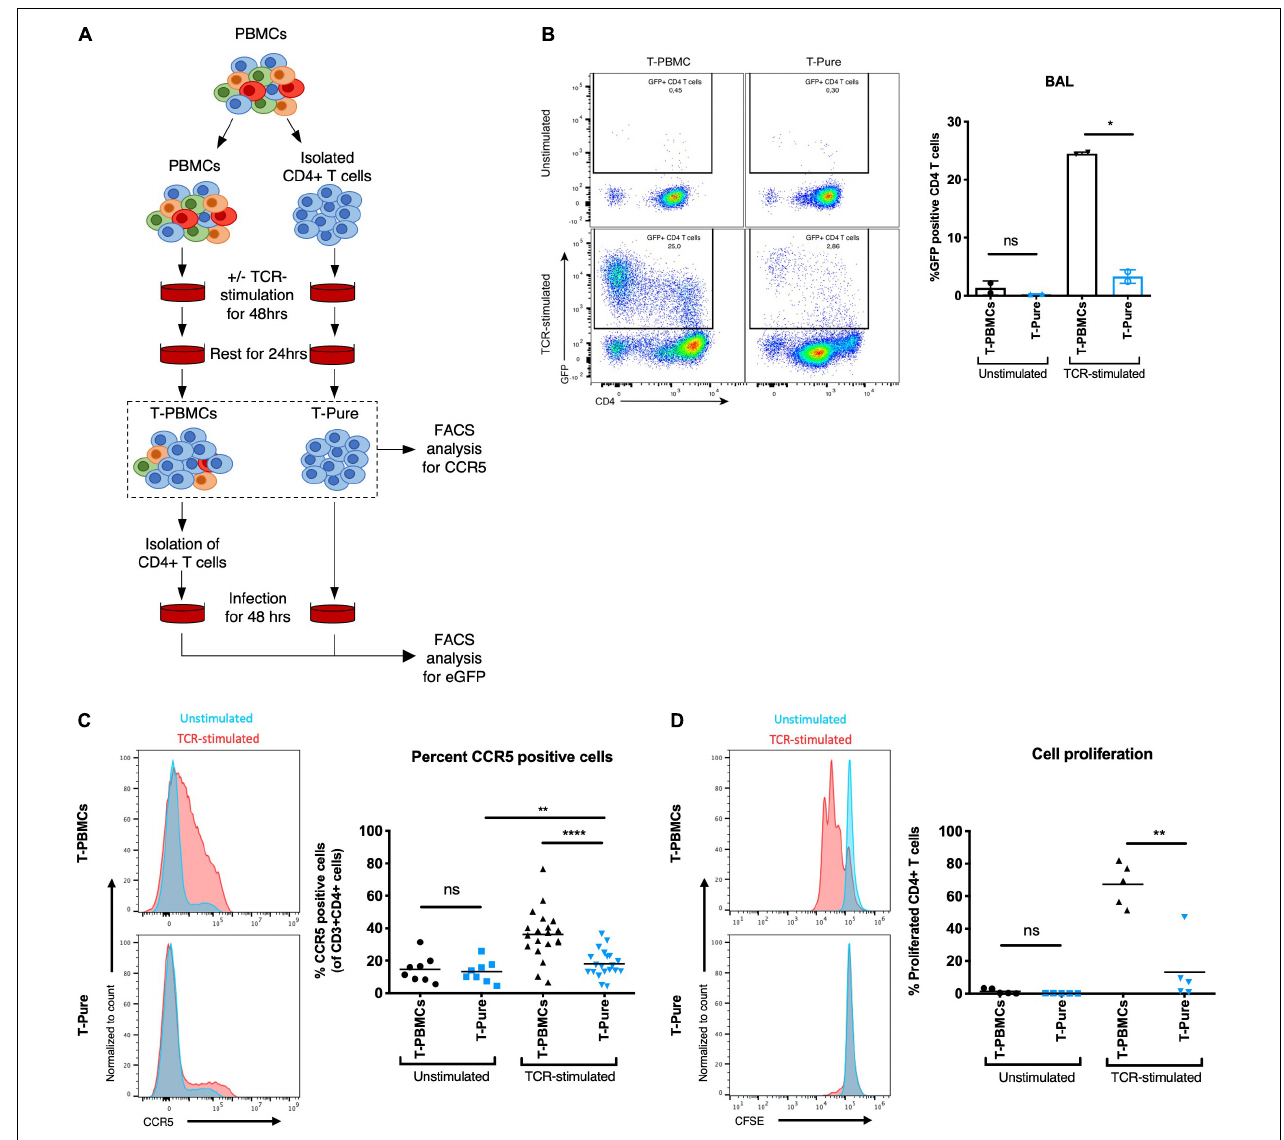
FIGURE 1 | CD4+ T cells from T- peripheral blood mononuclear cells (PBMCs) express elevated levels of cell-surface C-C chemokine receptor type 5 (CCR5) relative to those from T-Pure cultures. (A) Illustration of experimental setup to compare CD4+ T cells stimulated under different conditions. CD4+ T cells were mock-treated or stimulated with plate-bound α CD3(OKT3)/CD28(CD28.2) + IL-2 (termed TCR-stimulation) for 48 h either within the bulk PBMC population (termed T-PBMCs) or as a purified population of CD4+ T cells (termed T-Pure). Following T cell receptor (TCR)-activation, the cells were washed to remove antibodies and rested for another 24 h in the absence of stimulation. Cells treated in this manner were used for infection studies or analyzed by flow cytometry for CCR5 expression levels and proliferative capacity (B–D) . For infection studies CD4+ T cells were purified from the bulk T-PBMC population before infection was performed. (B) Cells treated as described in panel (A) were infected for 48 h with 100 ng p24/well of a CCR5-tropic Bal HIV-1 encoding an GFP reporter. Shown on the left are FACS plots showing the frequency of GFP+ cells. Shown on the right are quantitation of the data from two donors. (C) Cells treated as described in panel (A) were analyzed by flow cytometry for cell-surface levels of CCR5. Shown on the left are representative histograms from one donor showing cells expressing elevated levels of CCR5 amongst the T-PBMCs (top) vs. T-Pure cells (bottom) under unstimulated (blue) and TCR-stimulated (red) conditions. The graph on the right shows the proportions of CCR5+ cells under each of the culture conditions ( n = 8 donors for unstimulated and 20 donors for TCR-stimulated conditions). (D) To quantify cell proliferation, cells were stained with CFSE prior to the treatment conditions described in panel (A) . The proportion of CFSE (low) cells, corresponding to those that have undergone proliferation, is shown on representative FACS plots on the left. Shown on the right are quantitation of the data from n = 5 donors. Paired students t -test was used for all analyses. ns, not significant; * P < 0.05; ** P < 0.01; **** P < 0.0001.